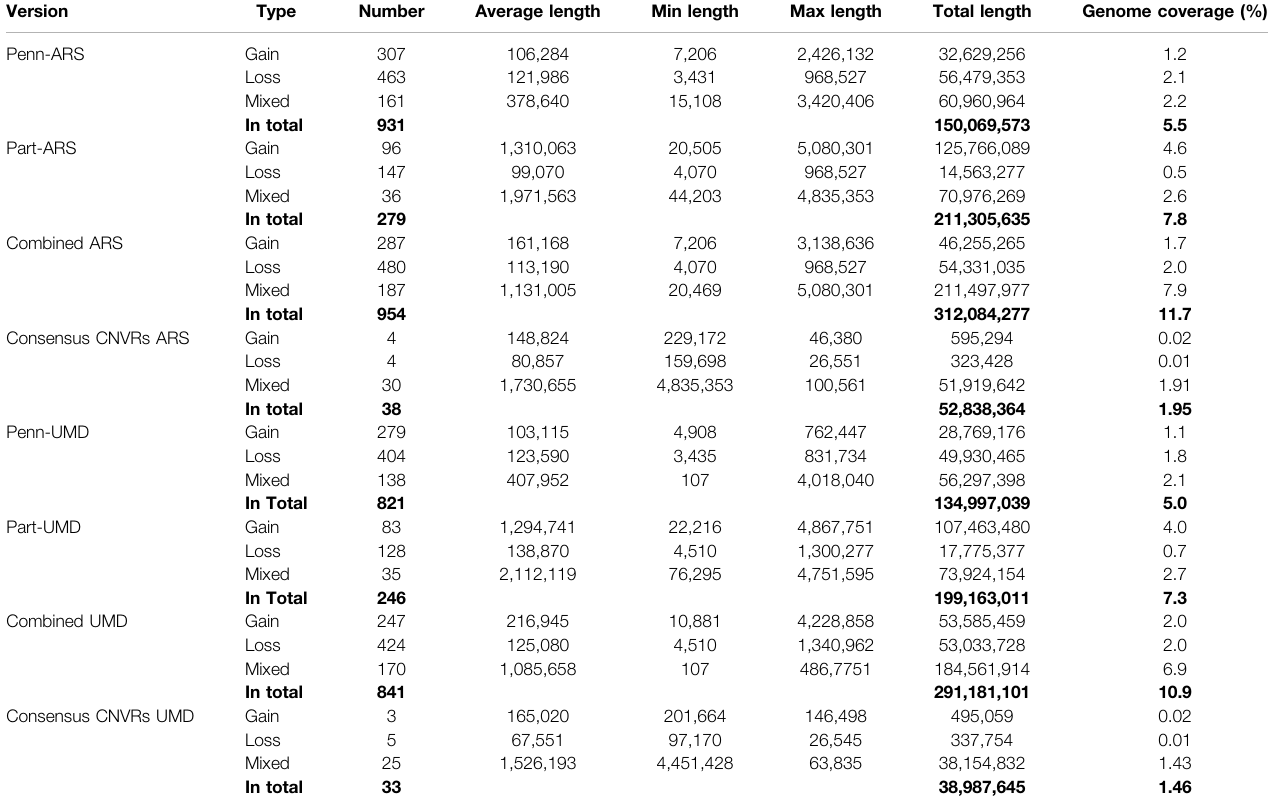
TABLE 3 | Statistical description of copy number variant region